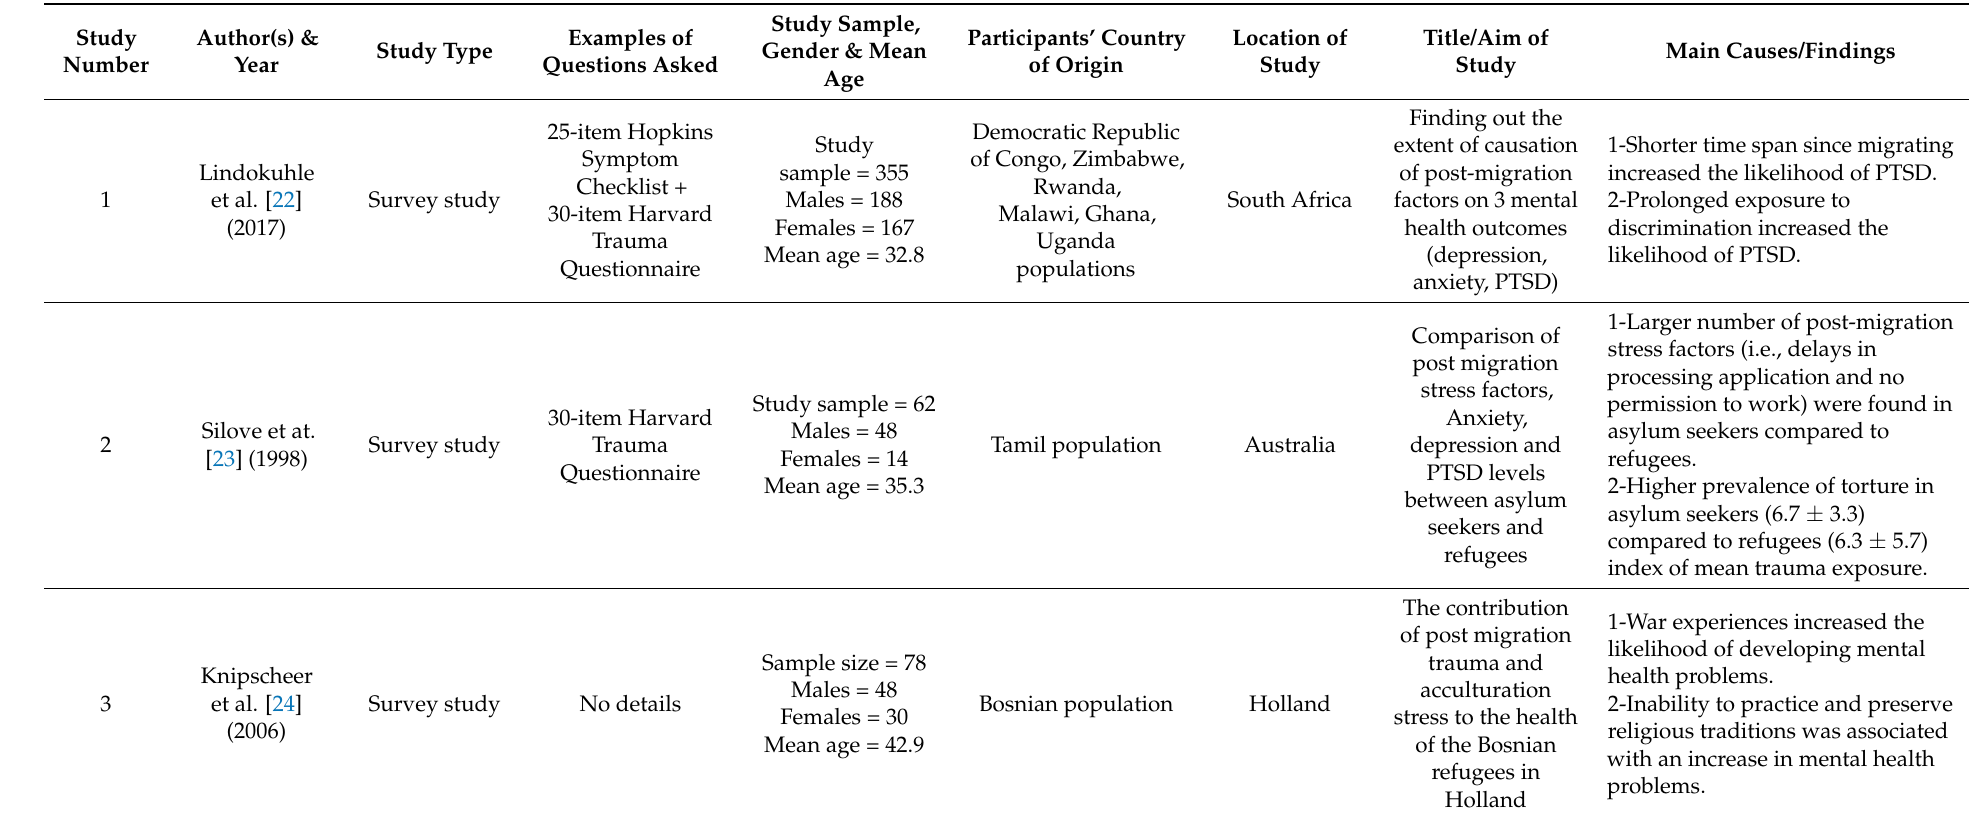
Table 2. Study characteristics and major